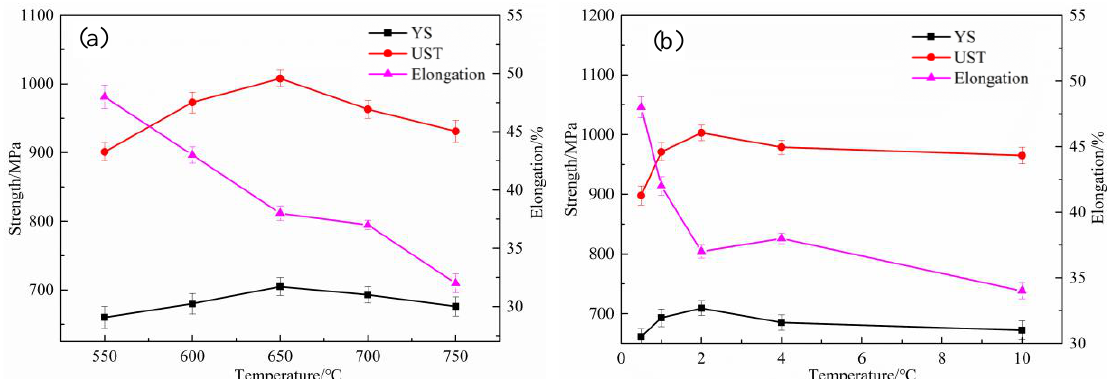
Figure 11. Influence of aging parameters on YS, UTS and elongation for the experimental steel. ( a ) Aging at different temperatures with 2h, ( b ) aging at 650 °C with different time.